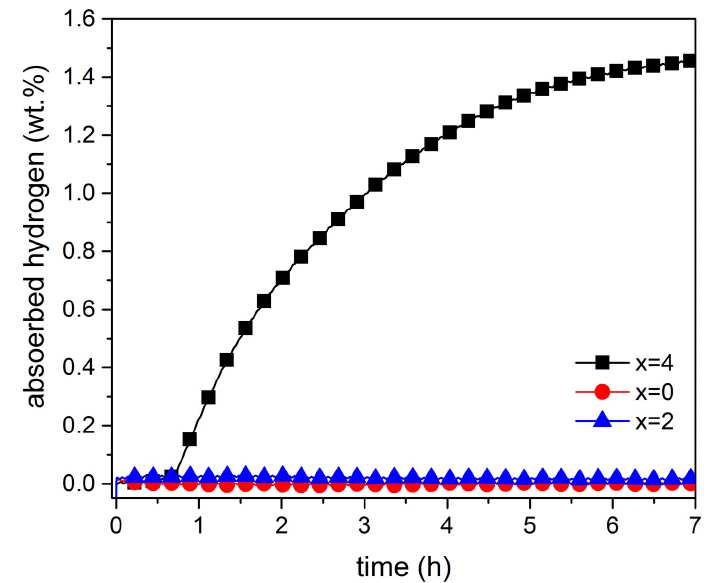
Figure 1. Activation curves at room temperature under 4500 kPa of hydrogen of single-melt TiFe + x wt.% Zr for x = 0, 2, 4.